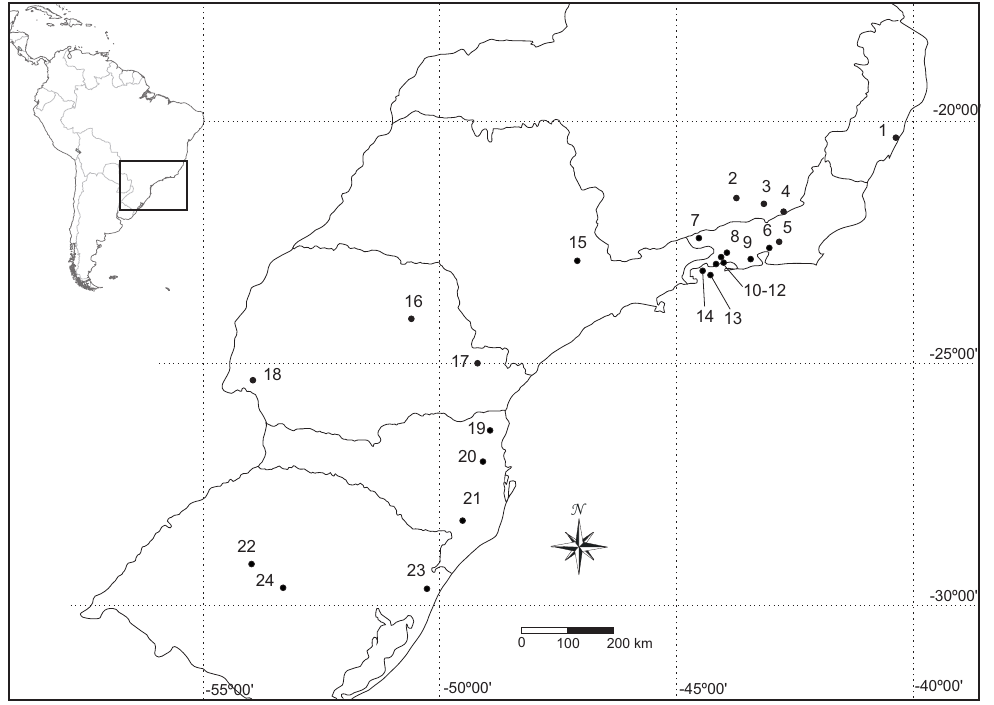
Figure 1. The study area in Brazil and the states where sampling was carried out. Few sampling sites were added. (1) Parque Estadual Paulo Cezar Vinha; (2) Ibitipoca; (3) Juiz de Fora; (4) Rio Preto; (5) Reserva Biológica de Araras; (6) Estação Ecológica Estadual Paraíso; (7) Serra da Concórdia; (8) Reserva Biológica do Tinguá; (9) Maciço da Tijuca, including sampling in the municipality of Rio de Janeiro (Parque Nacional da Tijuca, Parque da Gávea, Parque do Penhasco Dois Irmãos); (10-12) Seropédica and surroundings, Fazenda Portobello and Reserva Rio das Pedras; (13) Ilha Grande; (14) Ilha da Gipóia; (15) Santa Genebra Forest; (15) Fazenda Monte Alegre; (17) Parque Estadual do Campinho; (18) Parque Nacional de Iguaçú; (19) Parque Municipal Natural Nascentes do Garça; (20) Reserva de Sassafrás; (21) Pedras Grandes; (22) Parque Estadual do Turvo; (23) Agudos; (24)